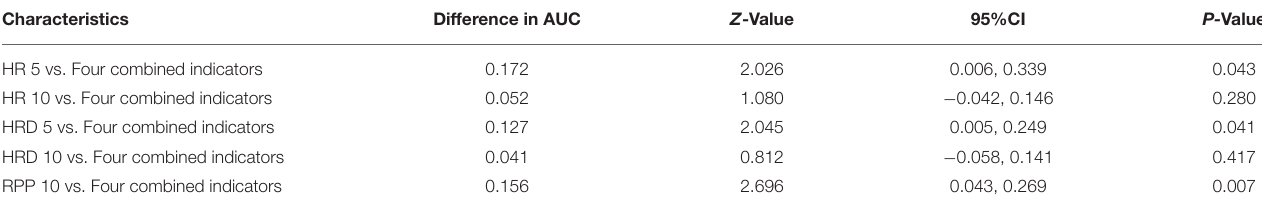
TABLE 6 | Z -test for comparing the predictive value of different